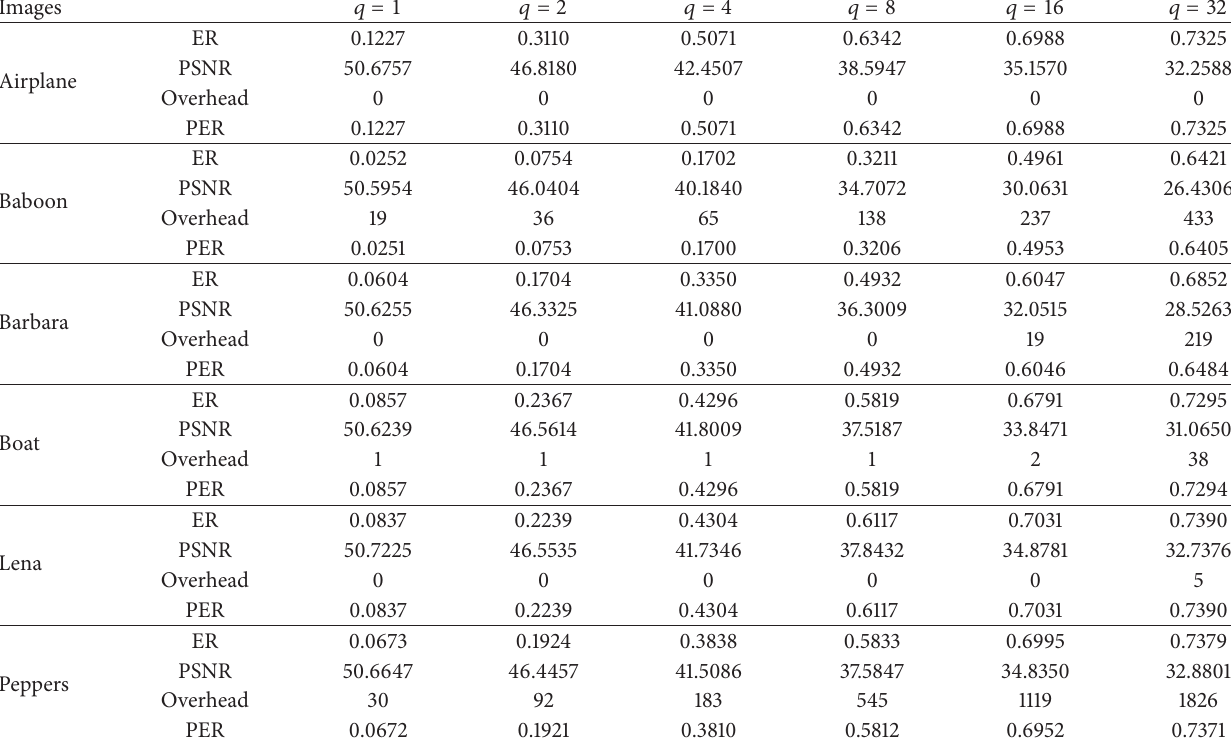
Table 3: Embedding rate and PSNR of different images (Miscellaneous gray level